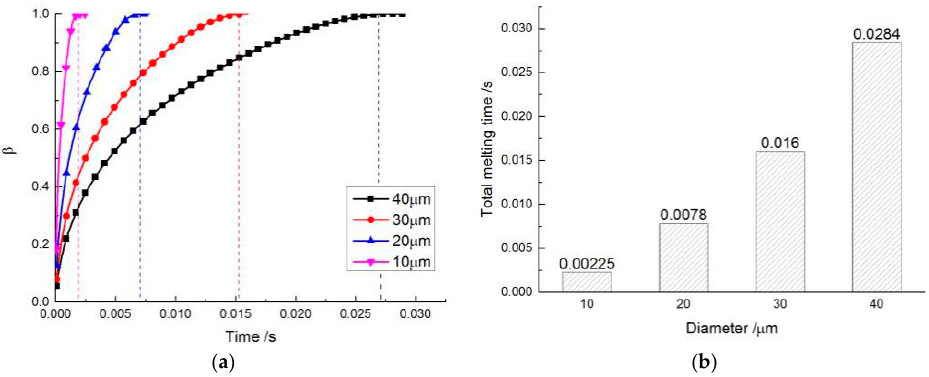
Figure 3. Melting process at different diameters. ( a ) Melting process; ( b ) Total melting time.